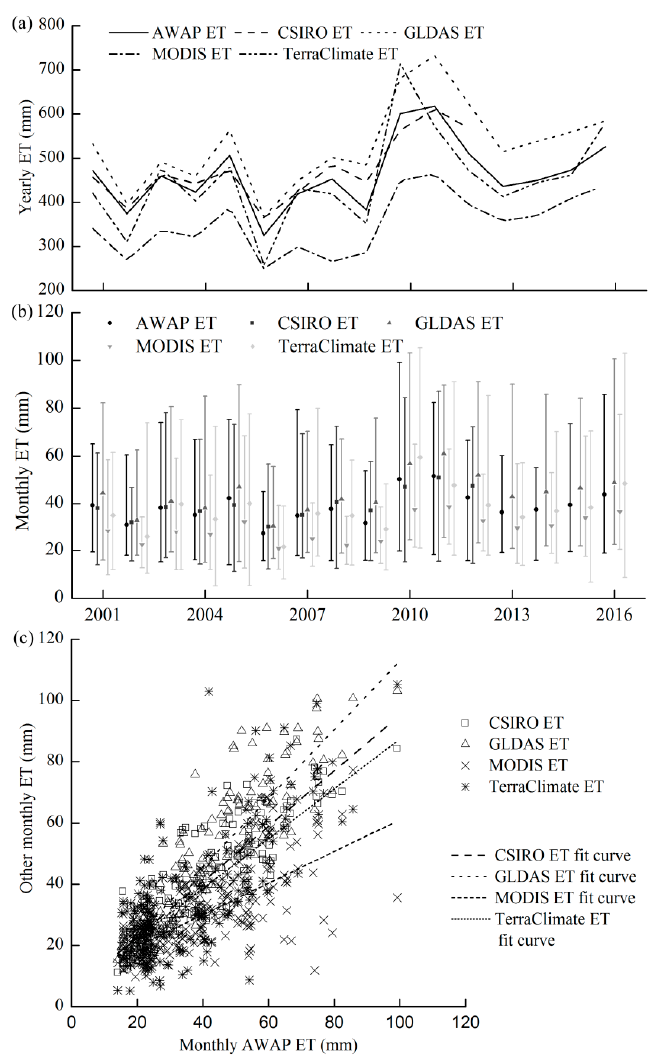
Figure 3. The comparison of annual and monthly ET products: ( a ) the annual ET, ( b ) mean monthly ET with the maximum and minimum values, and ( c ) the linear fit curves between AWAP ET and the other four ET products.